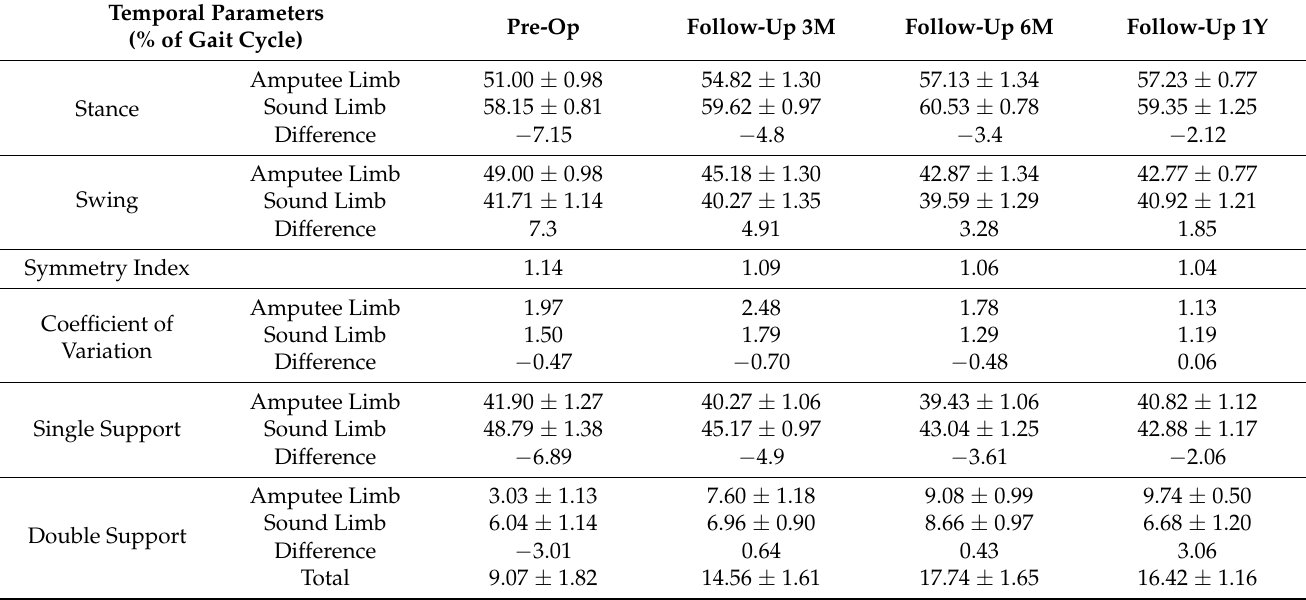
Table 3. Temporal gait parameters for the pre-operative gait analysis (socket-type prosthesis, ST) and the follow-up gait analyses (osseointegrated prosthesis, OI). Data are presented for the fast gait as mean ± standard deviation as a percentage of the gait cycle. Note: “Difference” means Sound limb—Amputee limb variable; symmetry index = 1.00 means perfect symmetry between stance phases of the two limbs.